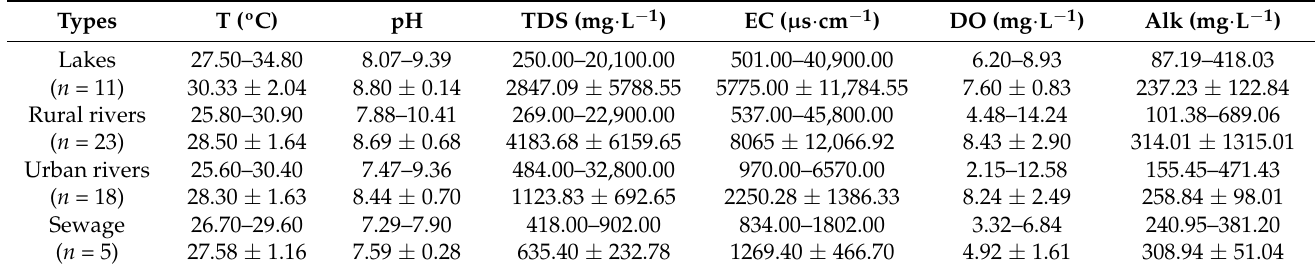
Table 1. Statistics of the environmental variables in surface water in Tianjin, China.